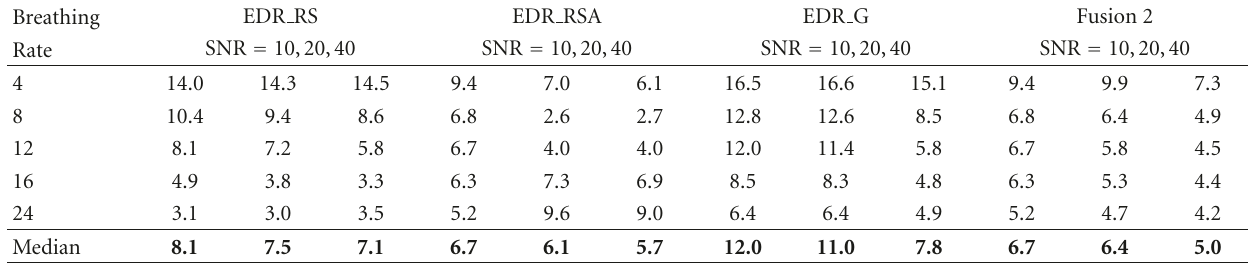
Table 1: Overall performance summary of each algorithm at SNRs of 10, 20, and 40 individually and the fusion results using the purity signal quality indices. All figures are RMS error in BPM. Note that both EDR RS and the QRS-Area (EDR G) methods perform poorly at low breathing rates, while EDR RSA performance degrades at higher respiratory